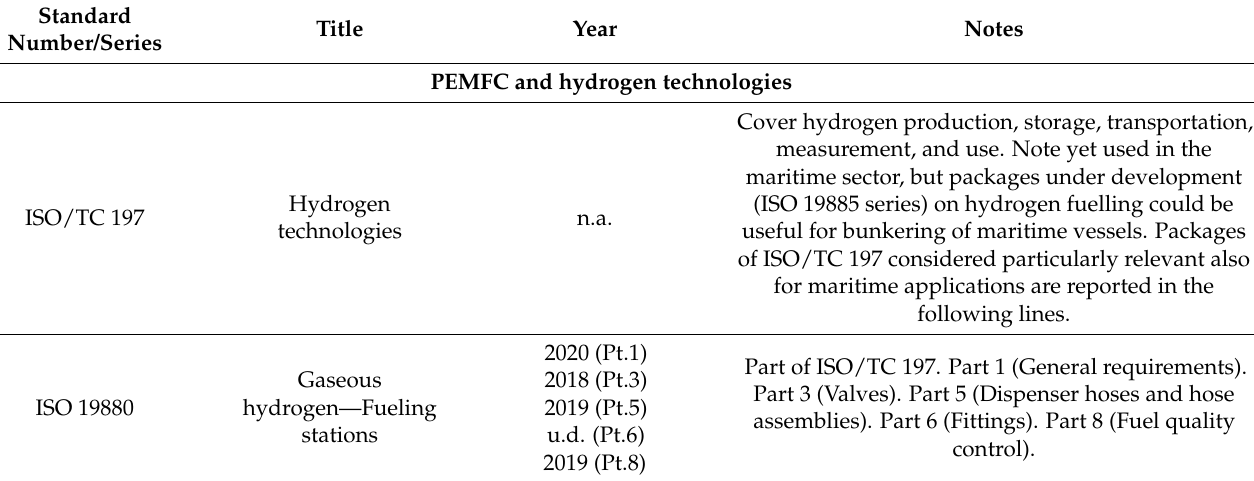
Table 8. International standards on PEMFC, hydrogen technologies, and batteries available for both shipping applications and sectors other than shipping that could be relevant for use in maritime applications. (u.d. = under development; n.a. = not applicable; amd. =